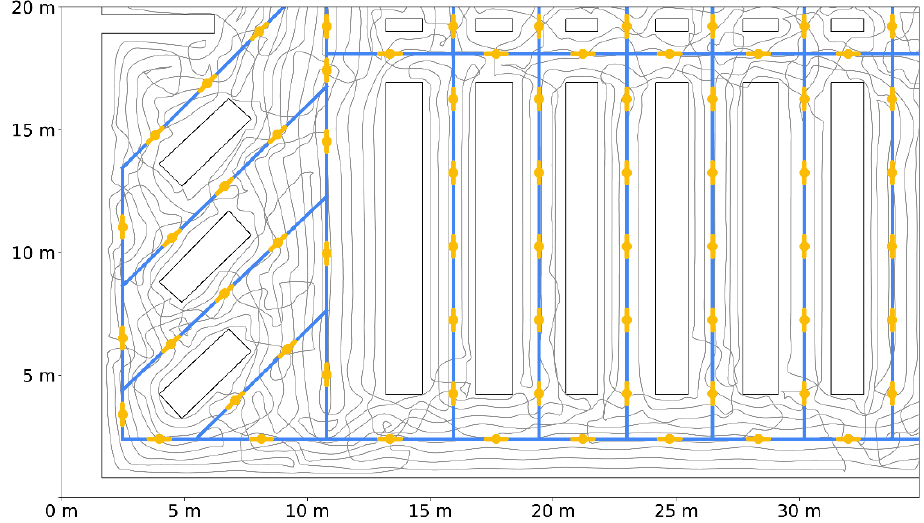
Figure 20. Large-scale Mobile-2D simulation: a part of the supermarket topology with IR AoA sensors, aisles graph, and cart trajectory.